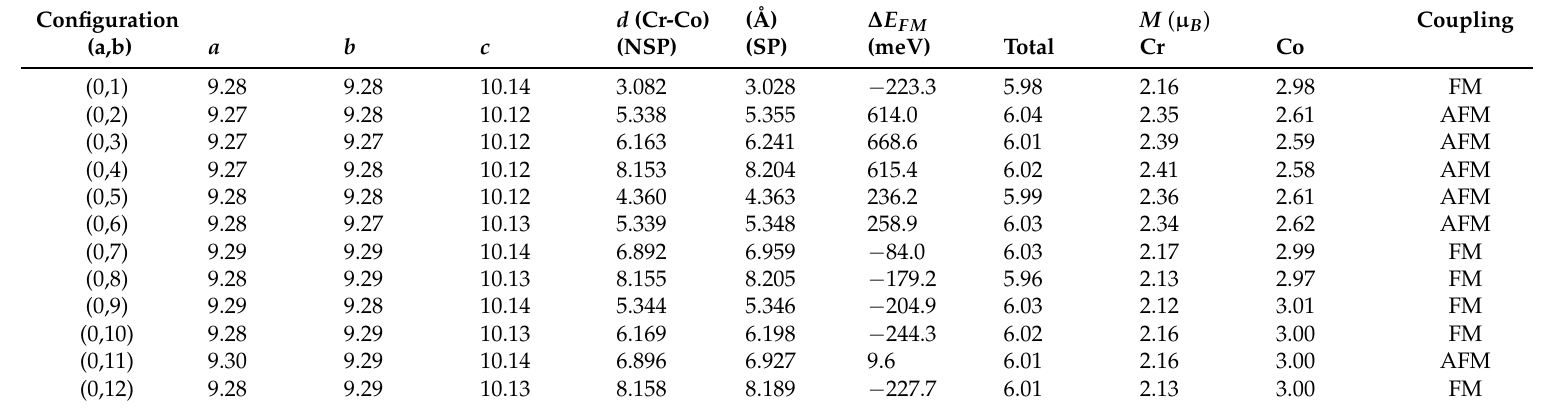
Table 1. Calculation results of 12 configurations for (Cr, Co)-codoped 4H–SiC, lattice parameters, Cr–Co distance ( d (Cr–Co)) before (NSP) and after (SP) relaxation, magnetization energy ( ∆ E FM ) and the magnetic moment ( M ) of total, Cr and Co atoms,